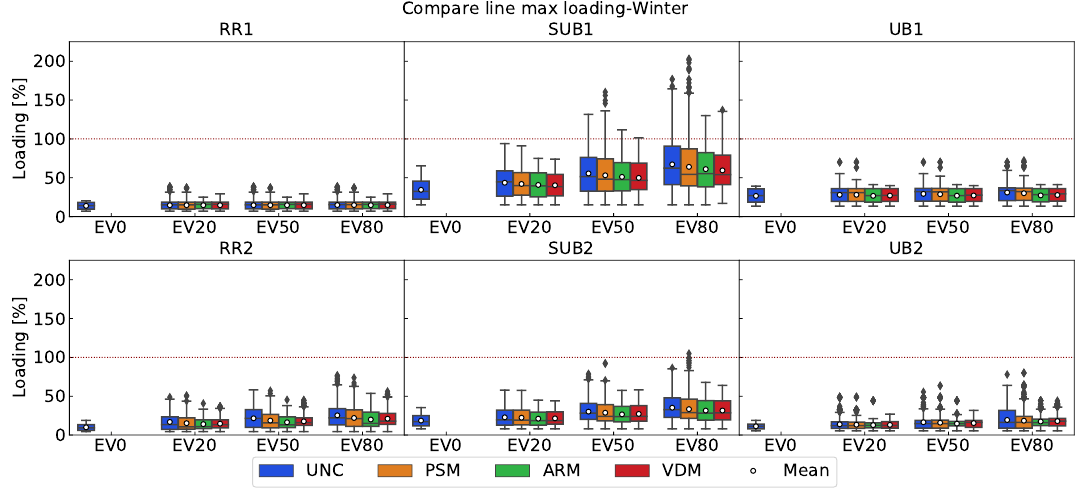
Figure 7. Comparison of maximum line loading distribution for one winter